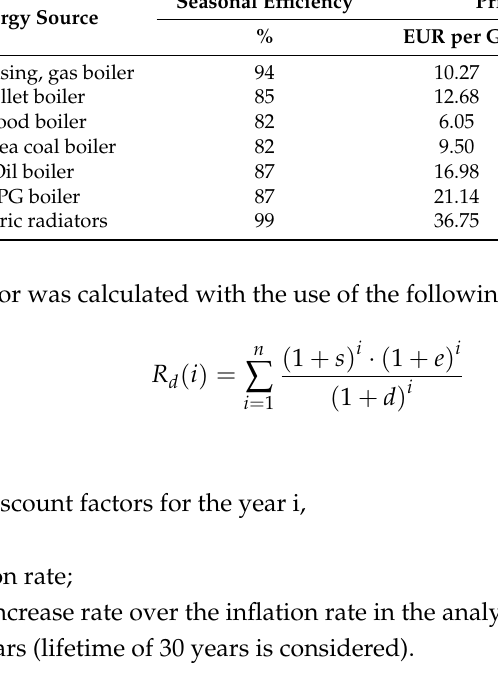
Table 5. The energy price with the tax (23%) pre GJ and kWh for chosen energy sources. Energy